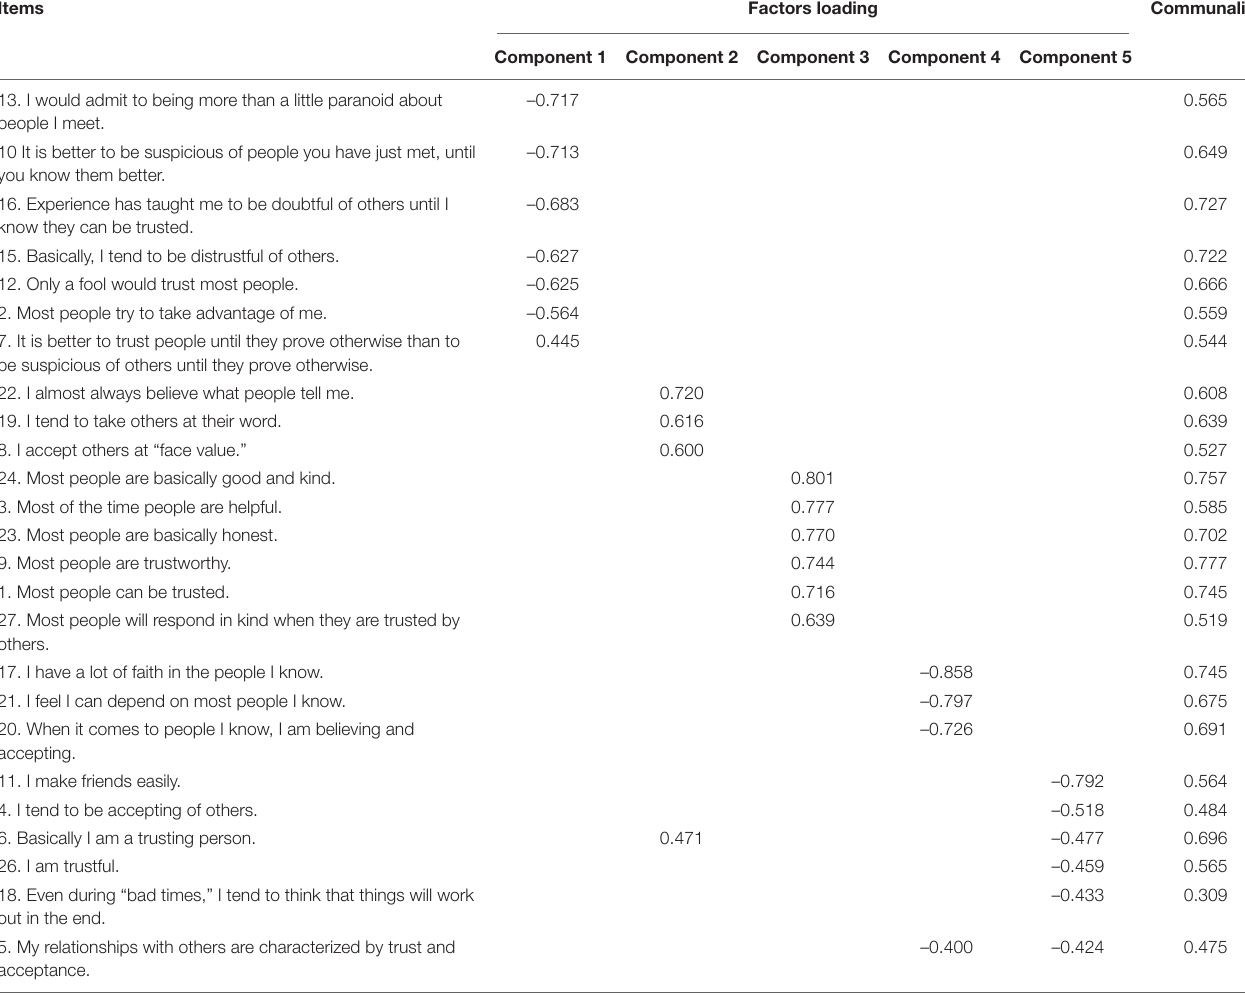
TABLE 3 | Factor loadings and communalities for the 27 items in Study 1.